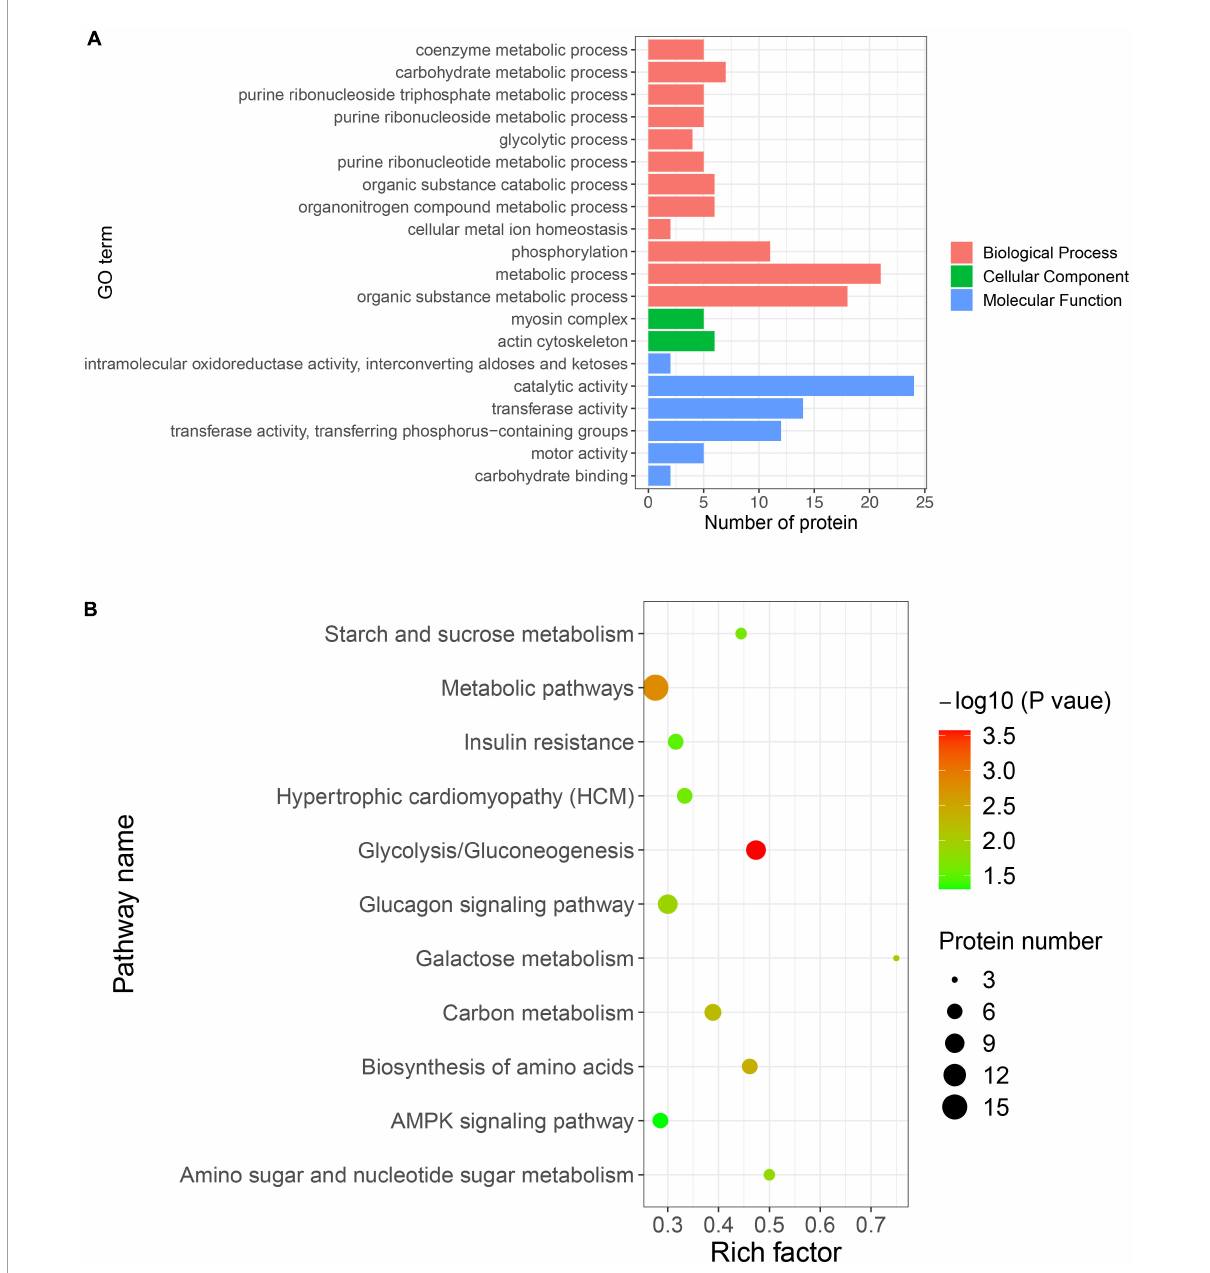
FIGURE5 Gene ontology (GO) and KEGG enrichment analyses of proteins with DEPSs. (A) Significantly enriched GO terms in biological process, cellular component, and molecular function. The x -axis represents the protein number, and y -axis represents the GO term. (B) Significantly enriched pathways. The x -axis represents the rich factor, and y -axis represents the pathway. Color and size of dots represent –log10( p -value) and the number of proteins,